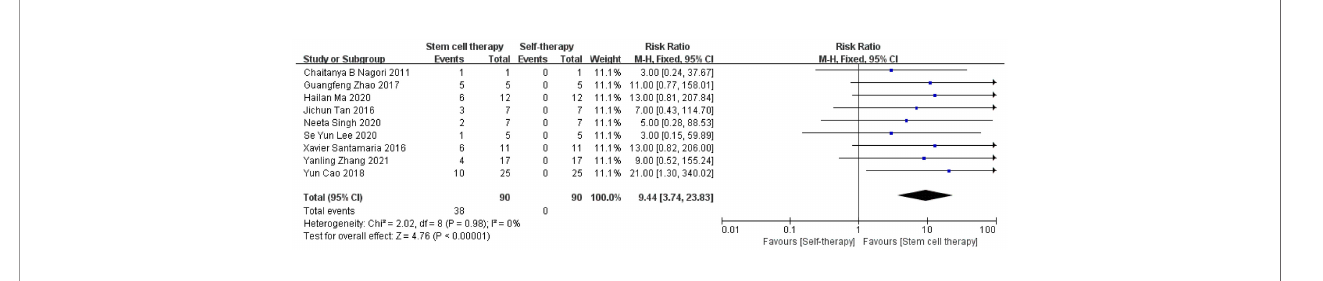
FIGURE 4 | Pregnancy outcome.